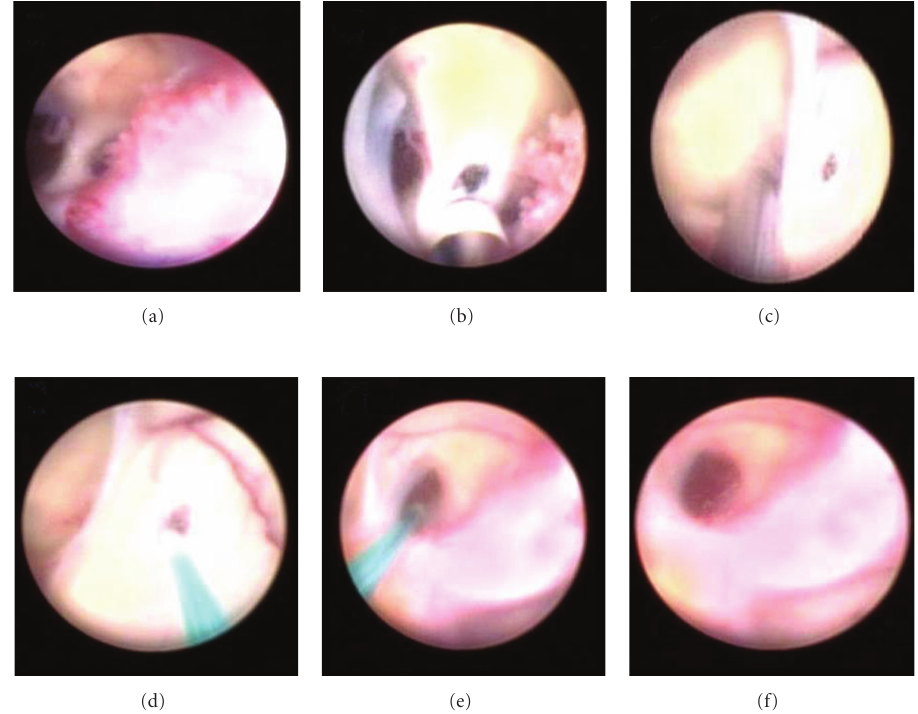
Figure 5: Screenshots of ventricular endoscopy (2006). Cystic walls were perforated, and the ventricular shunt was